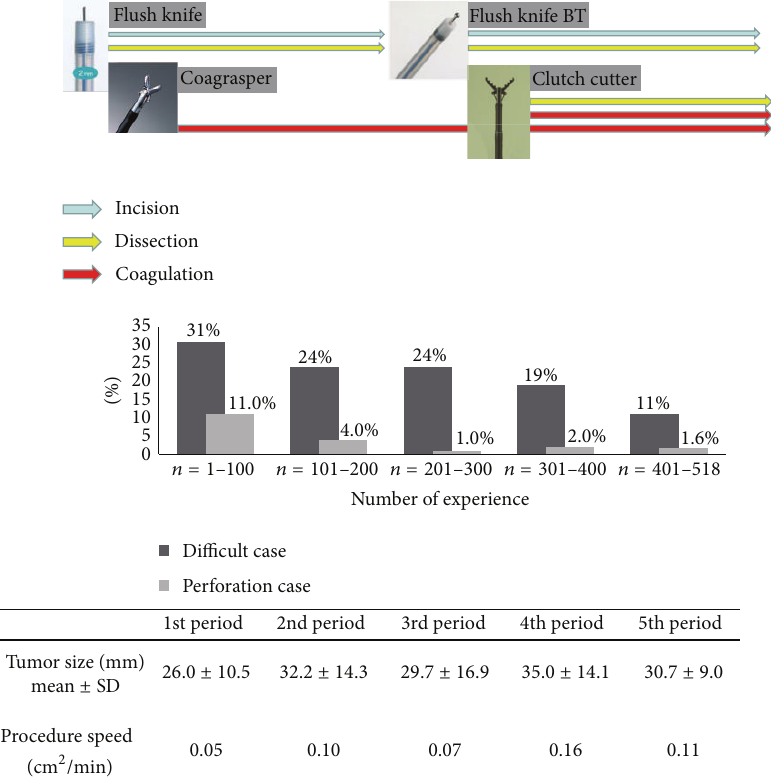
Figure 3: The change of ESD knife and forceps and learning curve for colorectal ESD. The rates of difficult cases in view of procedure time and perforation cases, tumor size, and procedure speed in 5 periods according to the experiences of colorectal ESD. With respect to the endoscopists’ experience, the rates of difficult cases and perforation decreased with more experience.